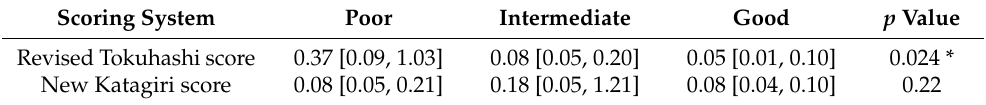
Table 5. Relationships of predictive prognostic scores with the preoperative CRP/albumin ratio. Scoring System